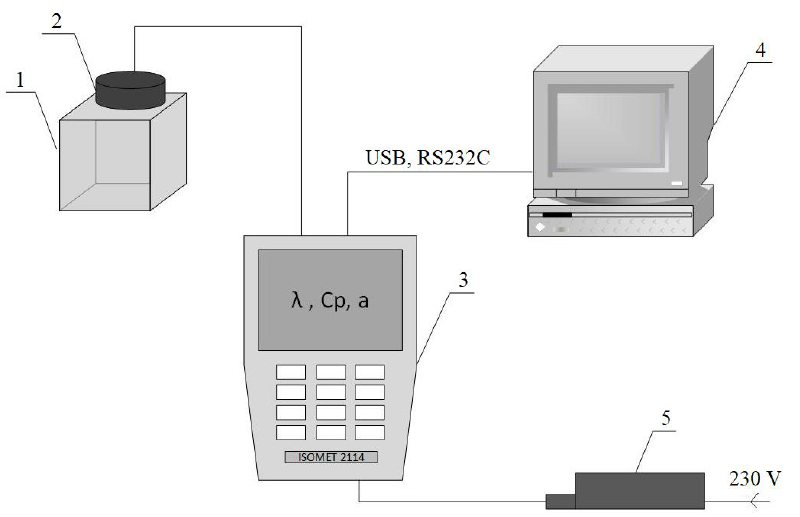
Figure 2. Scheme of the experimental stand for measuring the thermal properties of building materials [24,29]: 1—test sample, 2—probe, 3—Isomet 2114 device, 4—computer, 5—power supply. The device used features a wide measuring range and can be used, among other things, for insulation, building materials, plastics, glass, and minerals. The measuring range depends on the probe used, and covers λ values from 0.015 to 6.0 W/(m·K) and C v values from 0.04 to 3 MJ/(m 3 ·K). The meter has two optional types of probes: needle probes for soft materials, and surface probes for hard materials. Measurement data can be saved in the internal memory of the device or exported to a computer. In the presented experiment, the measurements were conducted using a surface probe (Figure 3).